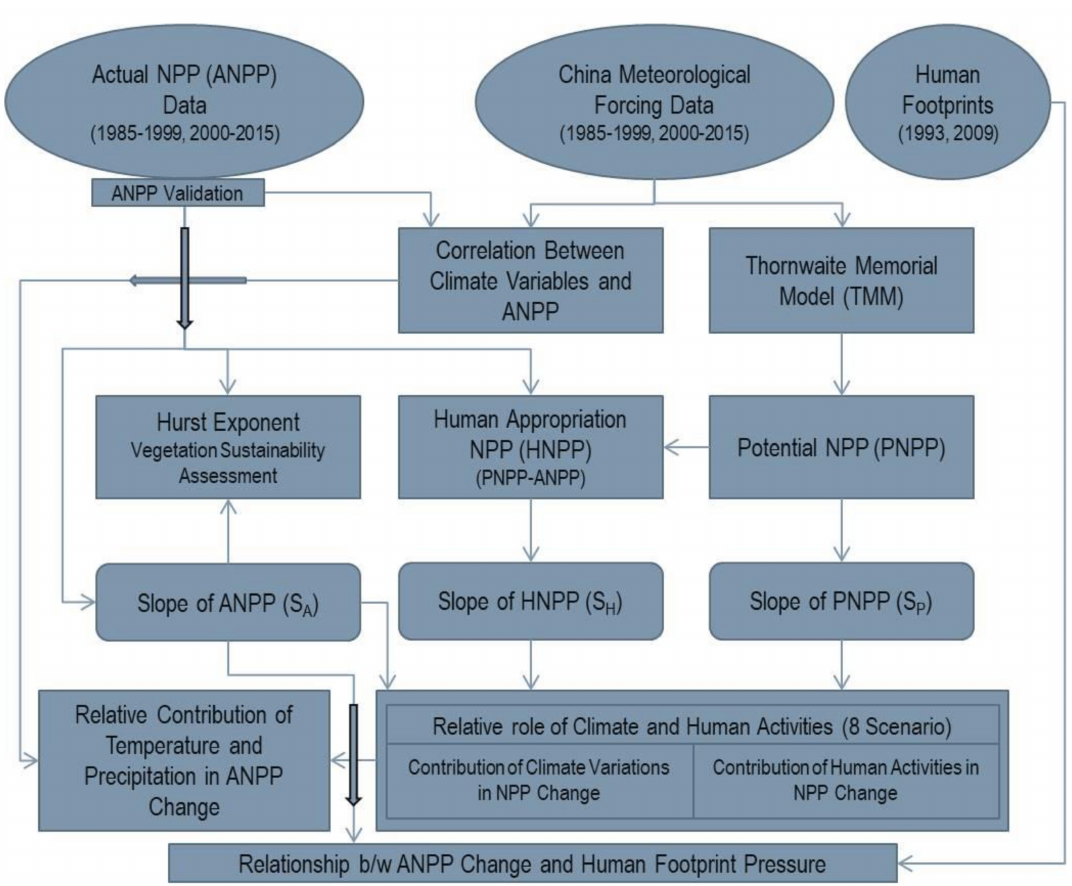
Figure 5. Methodological framework adopted for this study. NPP, net primary